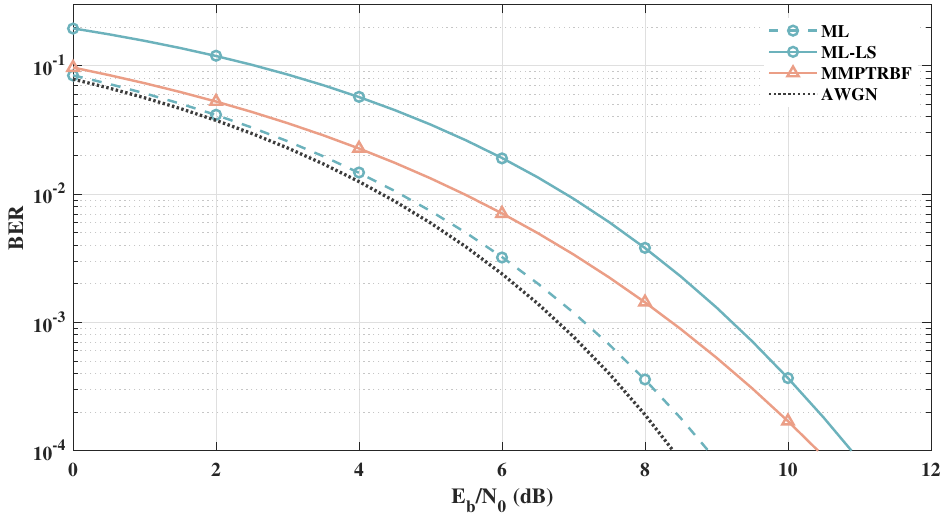
Figure 15. Systems with M T = M R = 4 antennas for 4-QAM